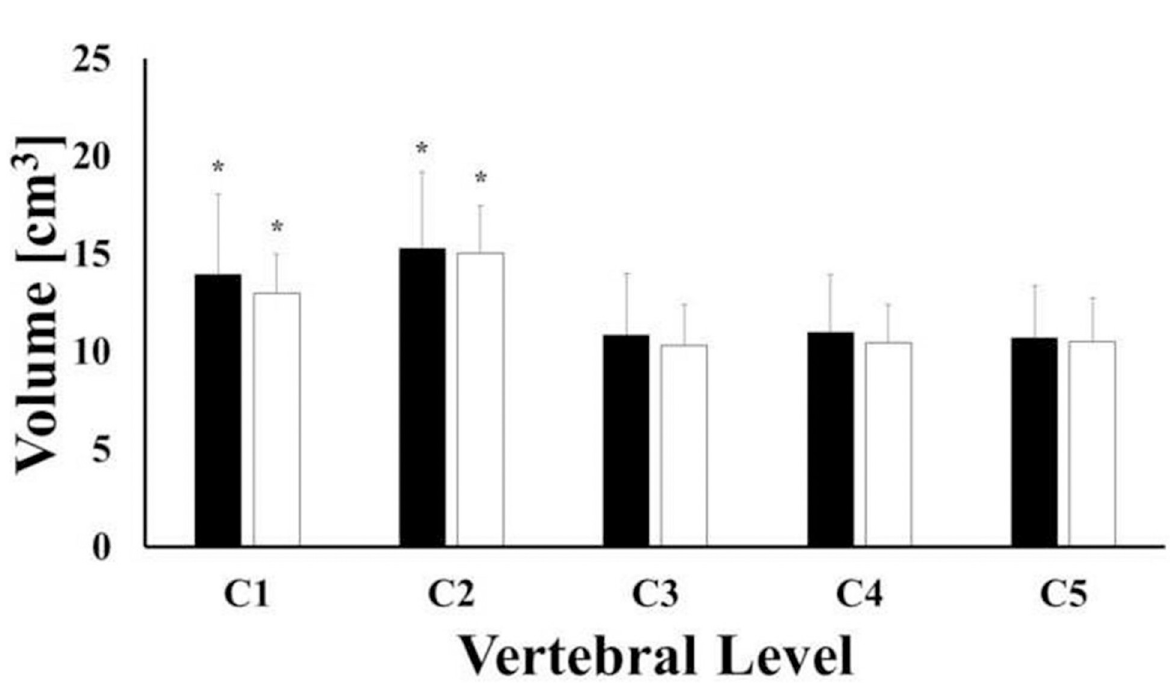
Fig 4. Mean values of bone volume across vertebral levels for female (white) and male (black) samples. Statistical significance (p-value < 0.05) is denoted by ( � ). Bars indicate one standard deviation.